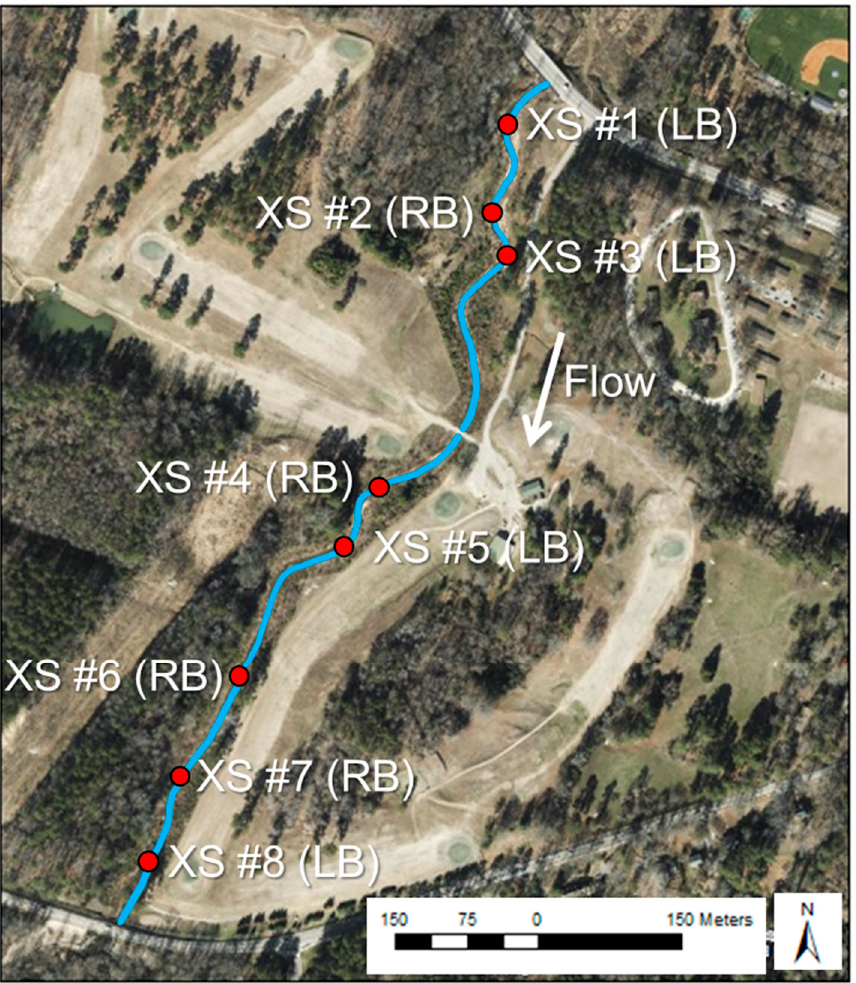
Figure 1. Restored reach of Richland Creek located within the Neuse River basin (USGS Hydrologic Unit 03020201) in the Northern Outer Piedmont ecoregion of the Piedmont physiographic region of North Carolina, USA. Chosen cross-sections (XS) are shown, indicating the banks that were evaluated using local-scale models as right-bank (RB) or left-bank (LB).